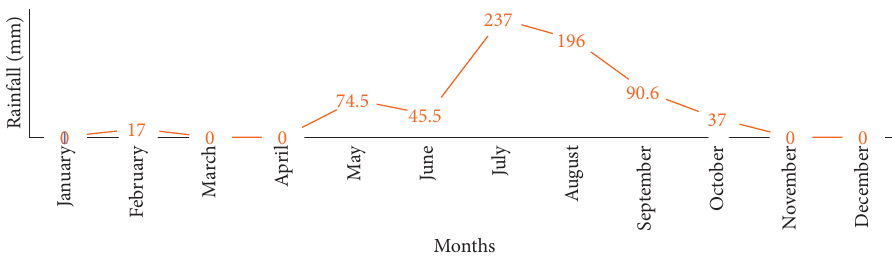
Figure 3: Evolution of rainfall in Kouare station during 2018 season. Table 1: Seed weight and chlorophyll content of mutant lines under nonstressed and stressed